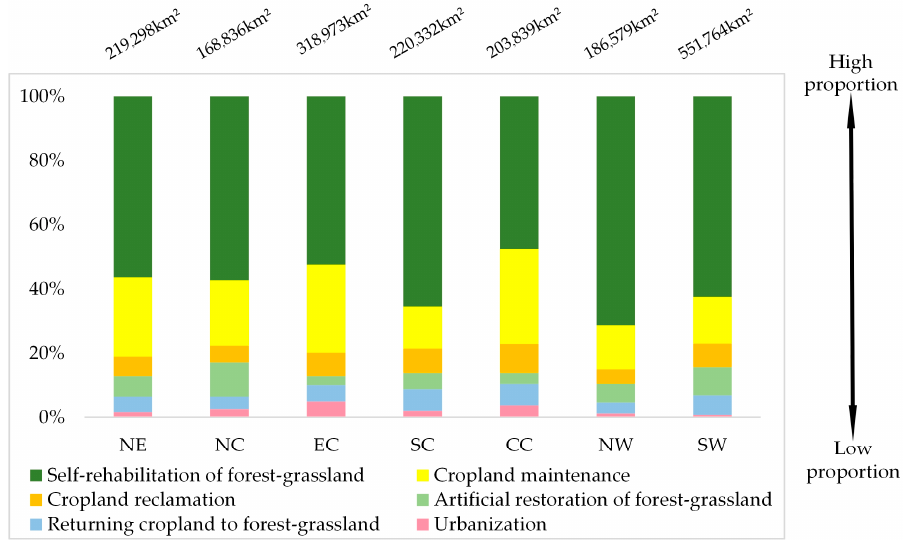
Figure 9. Proportions of the areas of the main land cover categories in the seven different